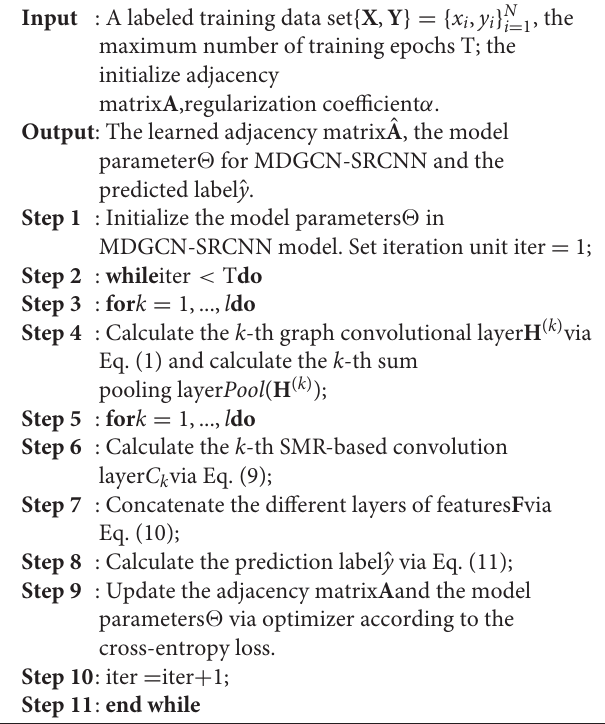
Algorithm 1: The training process of